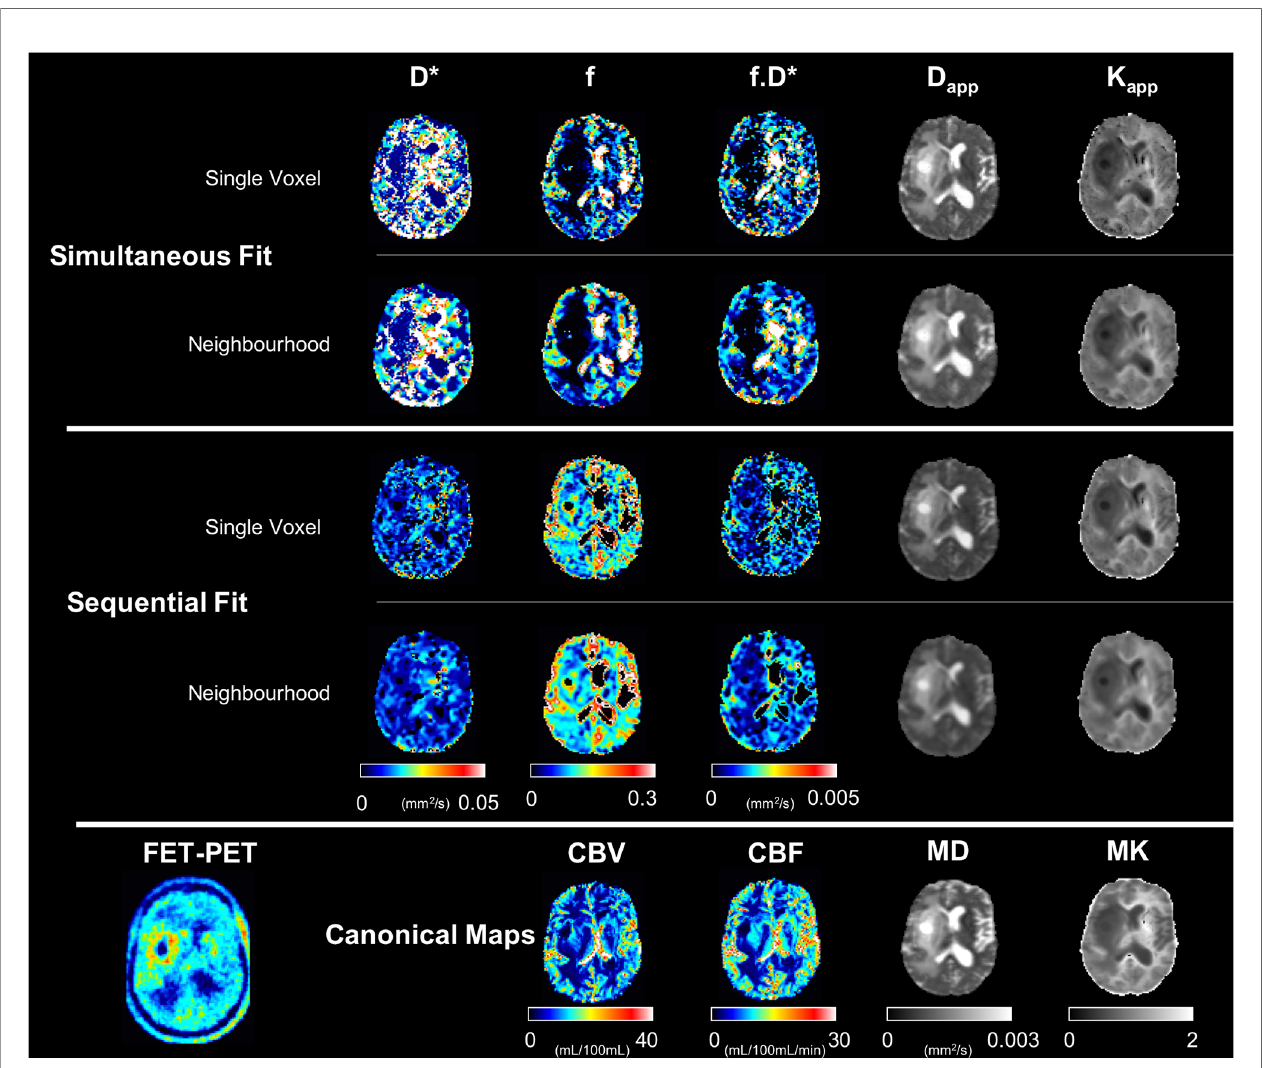
FIGURE 4 | Computed maps with the proposed protocol and all fi tting approaches for a representative subject. The canonical maps are shown in the last row. All scales within each metric are the